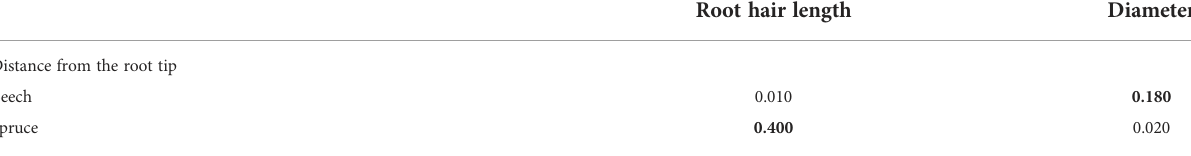
Root hair length